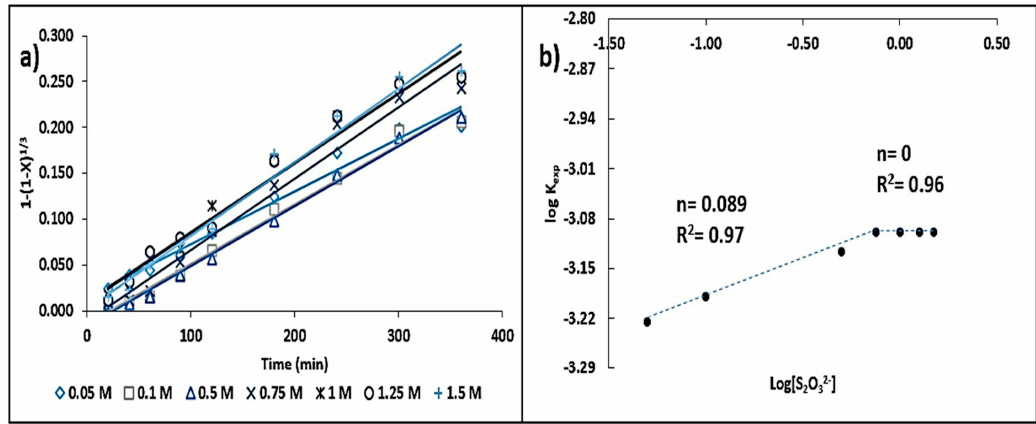
Figure 8. ( a ) Application of the chemical control model on the Ag conversion values as a function of time in order to study the [S 2 O 32 − ] concentration effect. V = 0.5 L, Mineral = 40 g ∙ L − 1 , P O2 = 1 atm, pH = 9.0, t r = 360 min, d = 74 μ m, [OH − ] = 0.1 mol ∙ L − 1 , T = 298 K, RPM = 670 min − 1 . ( b ) Dependence of log k exp as a function of log [S 2 O 32 − ].